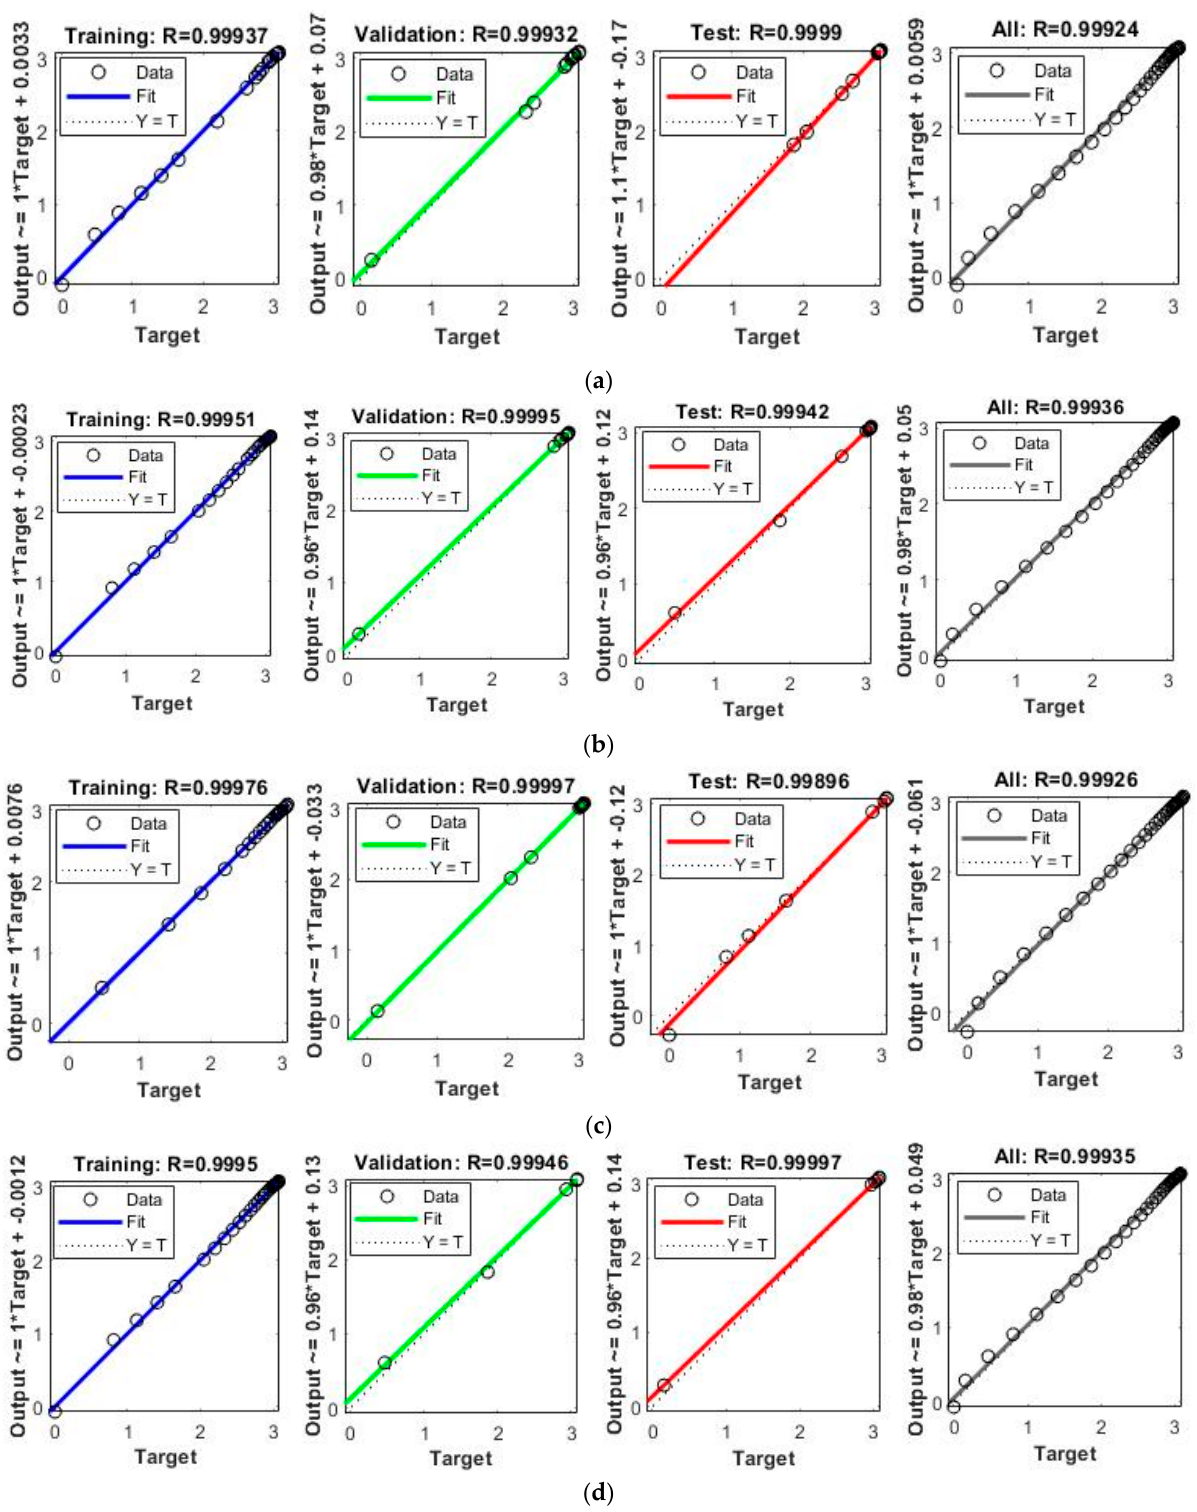
Figure 11. Regression analysis of training, validation, and testing for LMM ‐ NNs of the Dahl ‐ based hysteresis model of piezoelectric actuator. ( a ) LMM ‐ NNs Case 1. ( b ) LMM ‐ NNs Case 2. ( c ) LMM ‐ NNs Case 3. ( d ) LMM ‐ NNs Case 4.